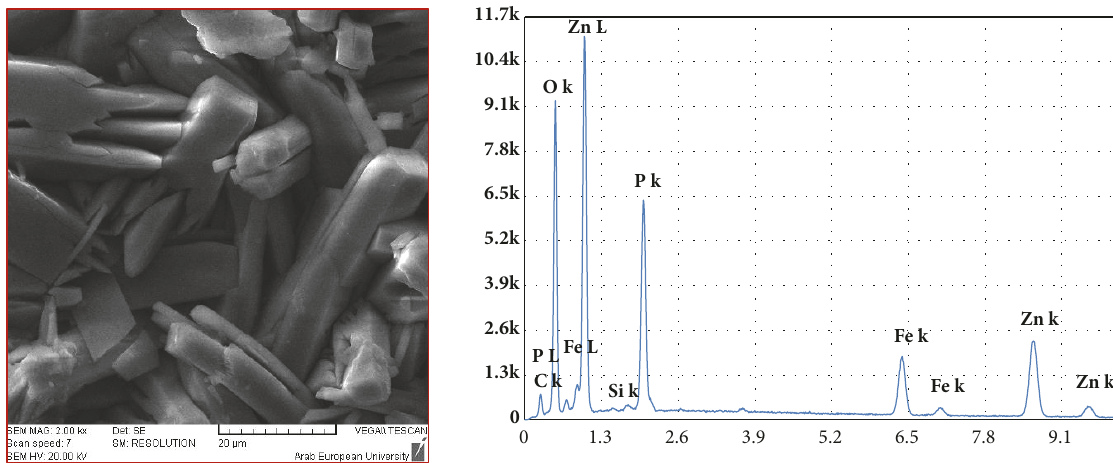
Figure 5: SEM and EDX of ZnP coating.